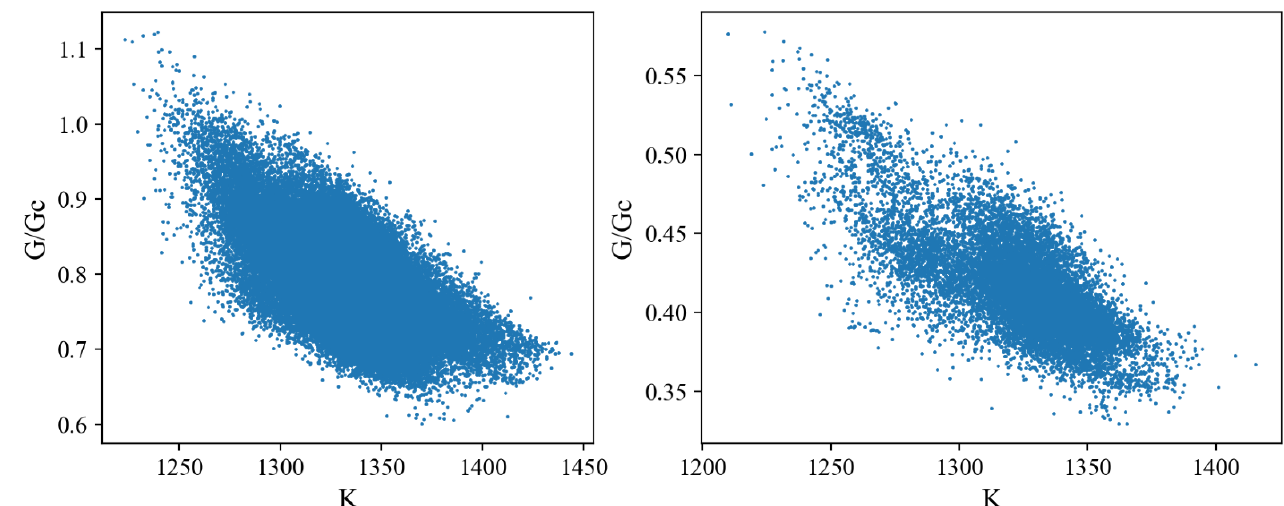
Figure 13. Scatter plots of the FEM dataset depending on the material behind the crack tip: ( left panel ): stiff material; ( right panel ): soft material. The unit of K is